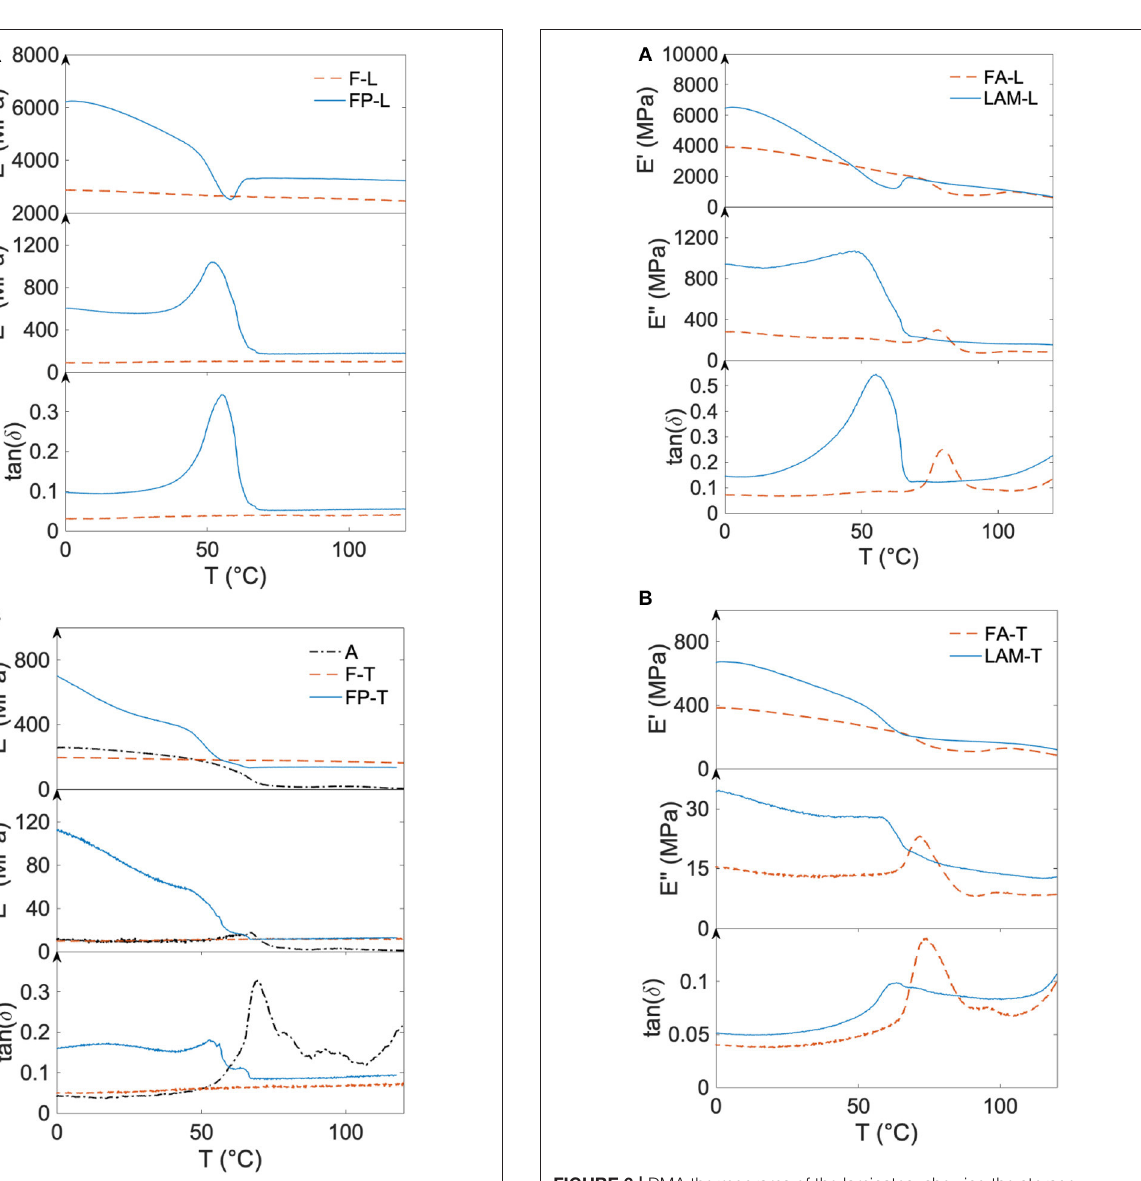
FIGURE 6 | DMA thermograms of the laminates, showing the storage modulus (E ′ ), the loss modulus (E”), and the loss factor (tan δ ). (A) Samples FA and LAM (longitudinal direction); (B) samples FA and LAM (transversal